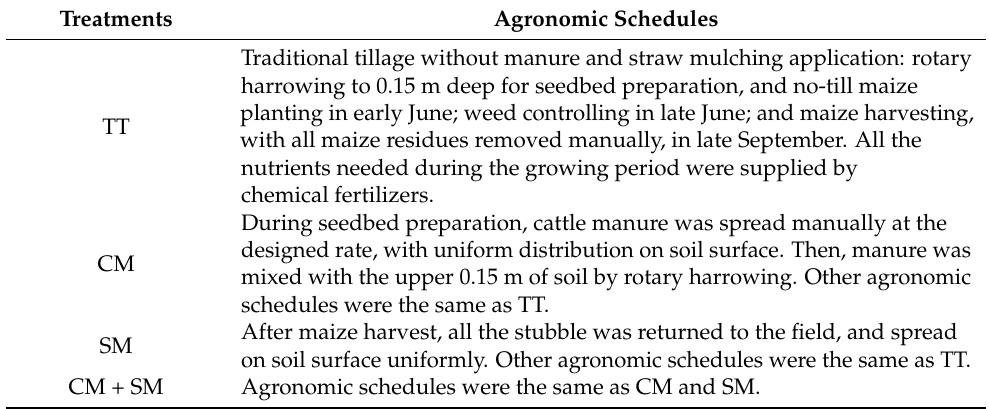
Table 3. Annual agronomic schedules for four treatments during crop season from 2016 to 2018. Treatments Traditional tillage without manure and straw mulching application: rotary harrowing to 0.15 m deep for seedbed preparation, and no-till